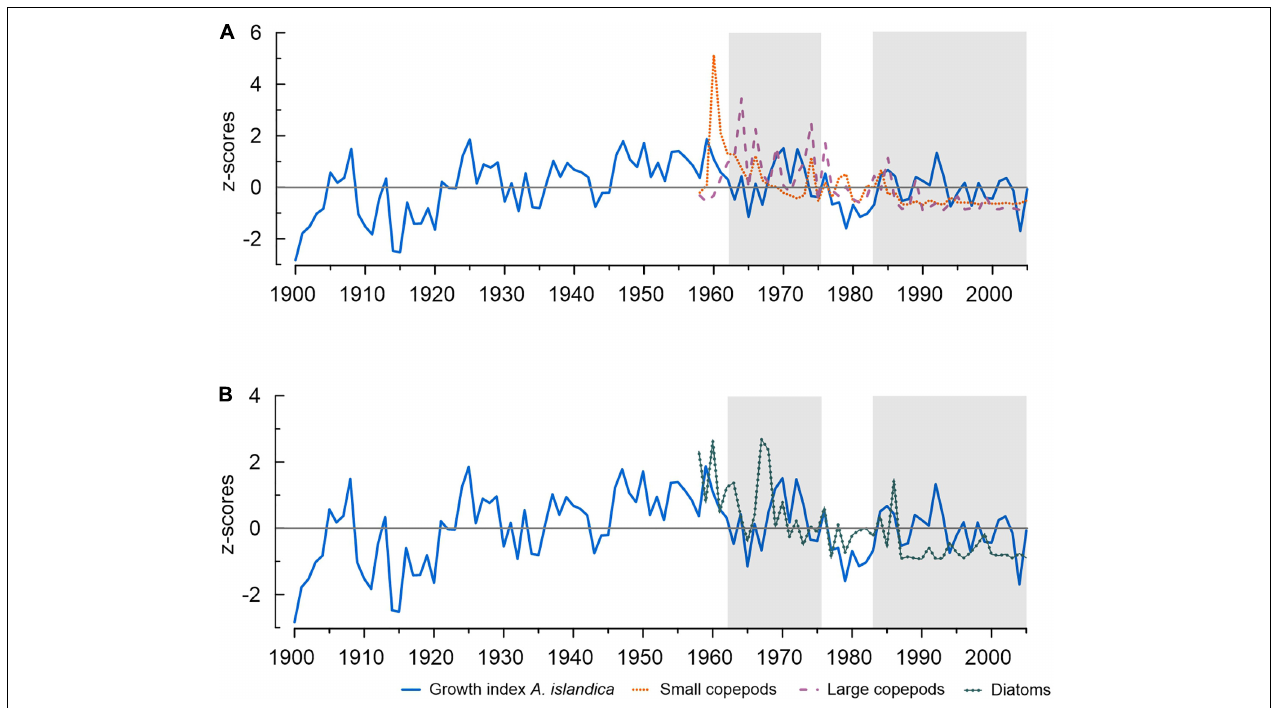
FIGURE 6 | Annual growth variability of A. islandica during 1900–2005. (A) Copepod and (B) Diatom abundances during 1958–2018. Periods of decreased synchronicity with surface (5 m) and water temperature at 56 m depth are shaded (see also Figure 3